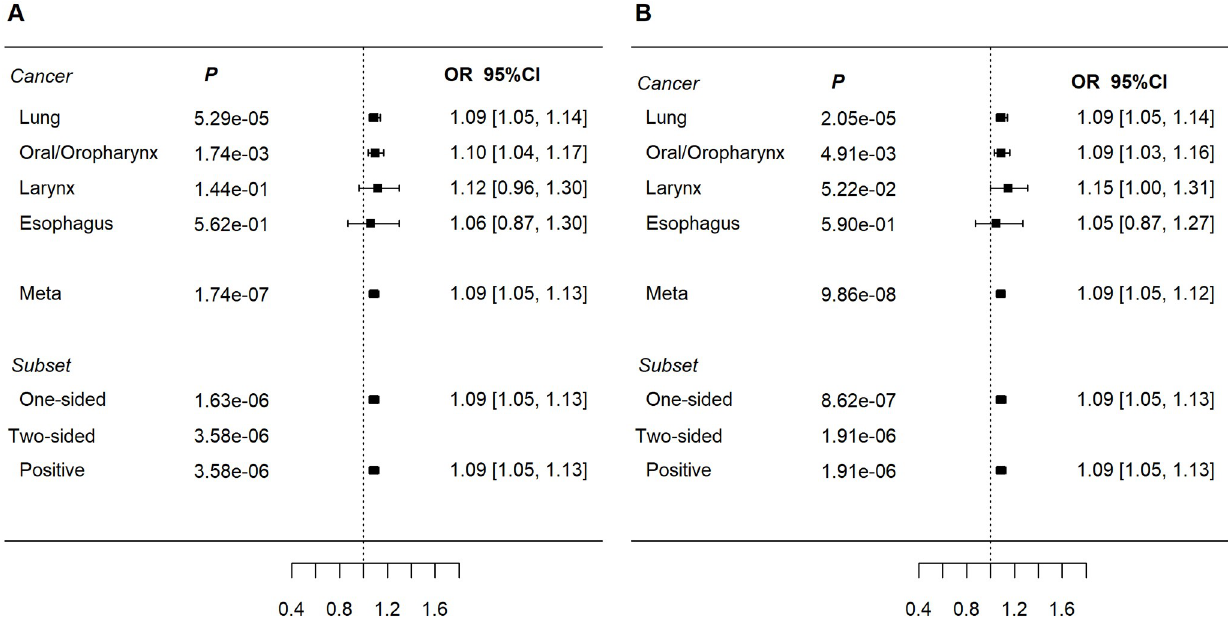
Fig 3. Forest plots of ORs for new aerodigestive SqCC-related loci. a) rs13181561 at 5q31.2 ( TMEM173 ); b) rs61494113 at 19p13.1 ( ABHD8 ). Subset refers to subset based meta-analyses